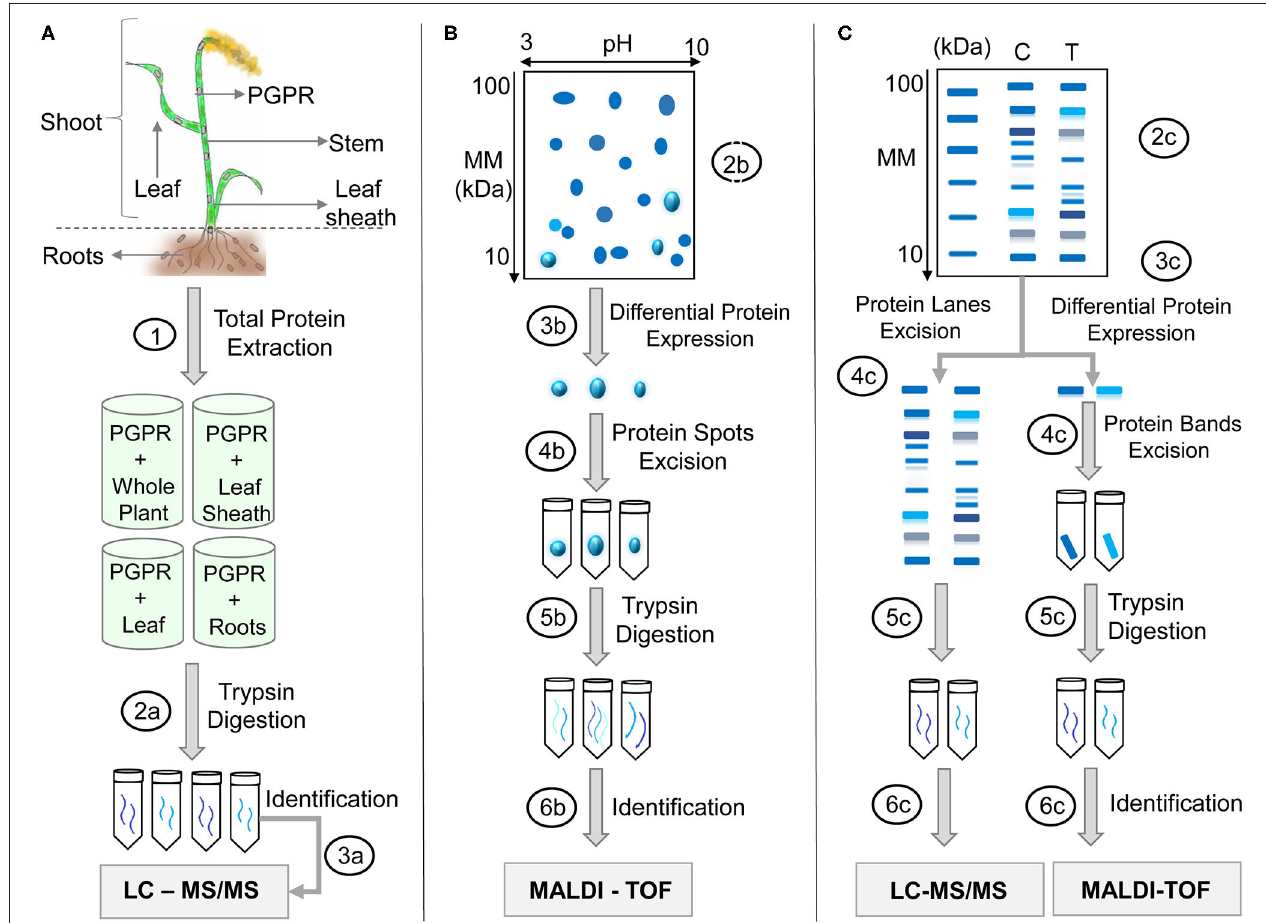
FIGURE 1 | Proteomics applied to PGPR—grasses interaction studies. (A) After colonization by PGPR, whole plant or parts of the plant (shoots, roots, leaf) is submitted to protein extraction (1). The extracted proteins can be: (2a) proteolyzed by trypsin and the peptides separated by (3a) liquid chromatography and its mass/charge analyzed by spectrometer mass (LC-MS/MS) with subsequent identification of the proteins by specific software. The peptides from different samples can be labeled with peptides or other molecules of known mass to perform simultaneous analysis and quantification. If the samples are analyzed individually, the quantification can be done by peptide counts known as label-free quantification. (B) Proteins are firstly separated by bidimensional electrophoresis (2D-SDS-PAGE) (2b), analyzed to differential expression (3b), the differentially expressed protein spots are removed (4b), the protein spots are digested with trypsin (5b), and the peptides analyzed in a MALDI-TOF spectrometer with subsequent identification of the proteins by computational analysis (6b). (C) The protein extract can be separated by unidimensional electrophoresis (SDS-PAGE) (2c), the entire lanes can be sliced in several pieces (4c), proteins are trypsinized (5c), and peptides analyzed by LC-MS (6c). On the other hand, differentially expressed proteins can be identified and extracted form the gel (4c), proteins are trypsinized (5c), and peptides analyzed by MALDI-ToF MS